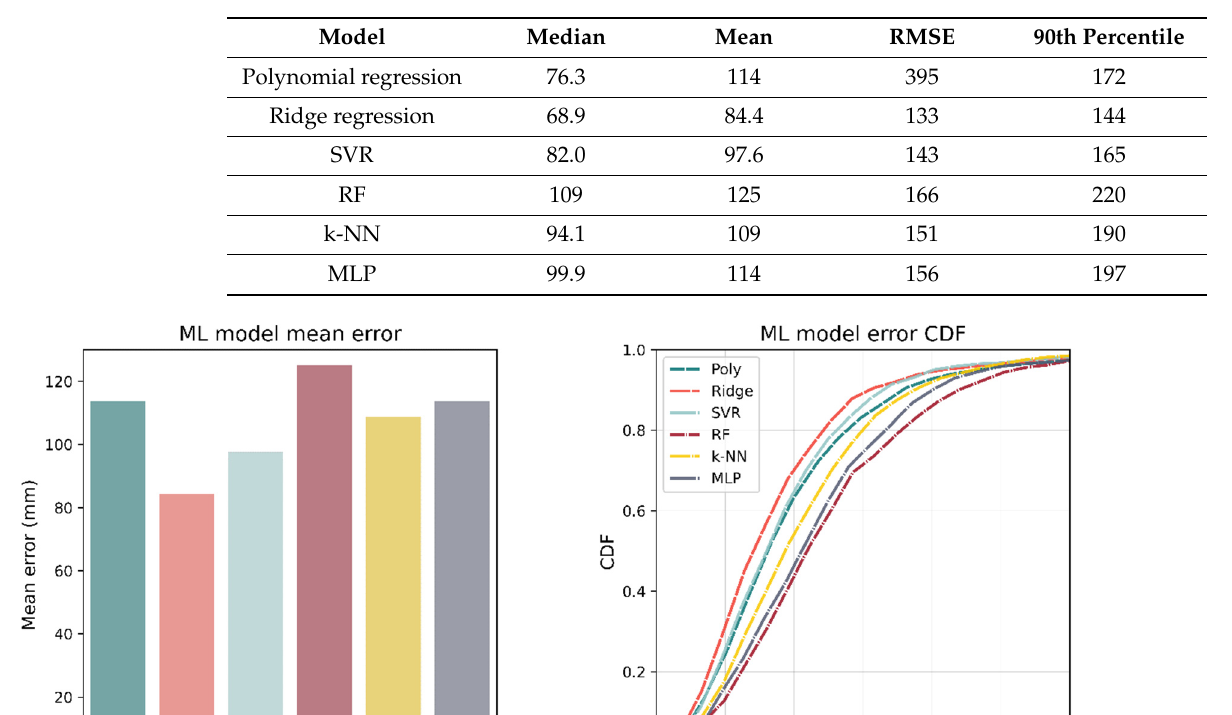
Table 4. Accuracy of the ML in mm after being retrained on the entire 80% training set and tested on the 20% test set.